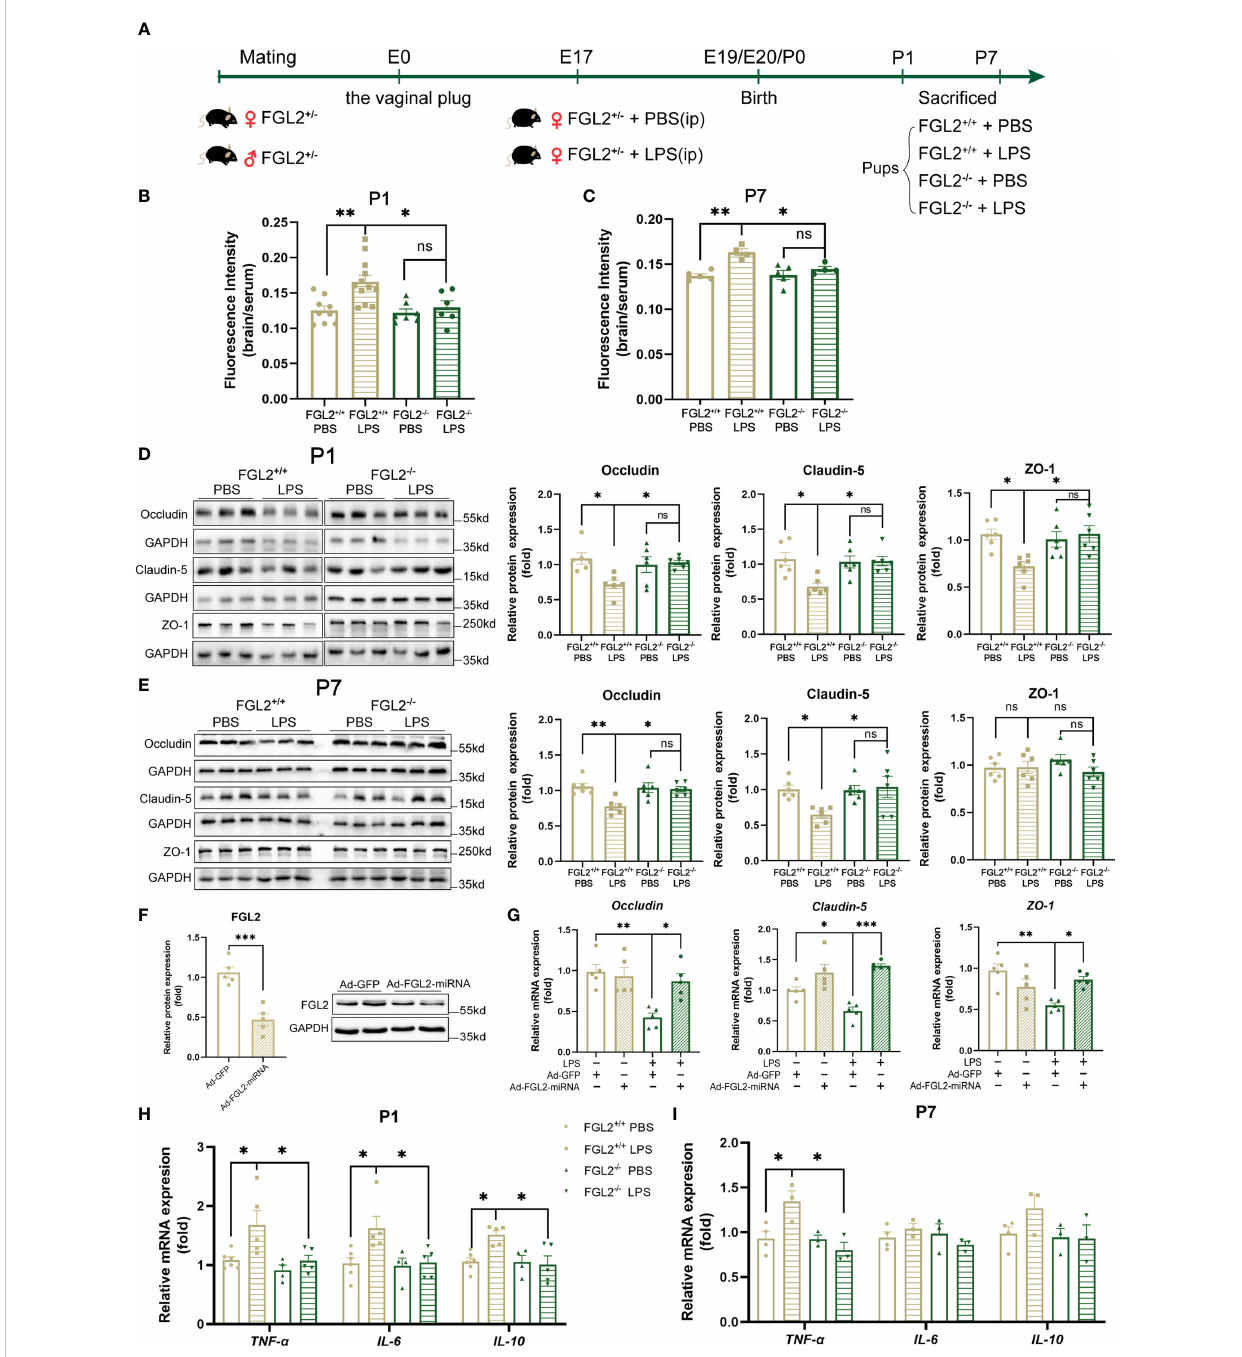
FIGURE 2 FGL2 de fi ciency attenuated maternal in fl ammation-induced BBB damage and neuroin fl ammation. (A) Experimental scheme of FGL2 +/- mice. FGL2 +/- dams were randomly injected with LPS (200 µg/kg) or PBS at E17. FGL2 +/+ and FGL2 -/- pups were sacri fi ced and their brains were collected at P1 and P7. (B) The permeability of BBB measured by NaF in pups at P1 ( n = 9:12:7:6). (C) The permeability of BBB measured by NaF in pups at P7 ( n = 5:4:5:4). (D) The protein expressions of Occludin, Claudin-5, and ZO-1 in brain at P1 ( n = 6). (E) The protein expressions of Occludin, Claudin-5, and ZO-1 in cortex at P7 ( n = 6). (F) The protein expression of FGL2 in BMECs ( n = 5). BMECs were infected by Ad-FGL2-miRNA or Ad-GFP for 48h. (G) The mRNA levels of Claudin-5 , Occludin , and ZO-1 in BMECs ( n = 5). BMECs were infected by adenovirus for 48 h before treatment of LPS (5 m g/ml) or PBS for 24h. (H) The mRNA levels of TNF- a , IL-6 , and IL-10 in brain at P1 ( n = 6:5:4:5). (I) The mRNA levels of TNF- a , IL-6 , and IL-10 in cortex at P7 ( n = 4:3:3:3). The data was expressed as mean ± SEM and was the representative of at least three independent experiments. Statistical differences were assessed by unpaired two-tailed Student ’ s t test for two groups and one-way ANOVA with Tukey ’ s post-hoc test for four groups. ns P >0.05, * P <0.05, ** P <0.01, *** P